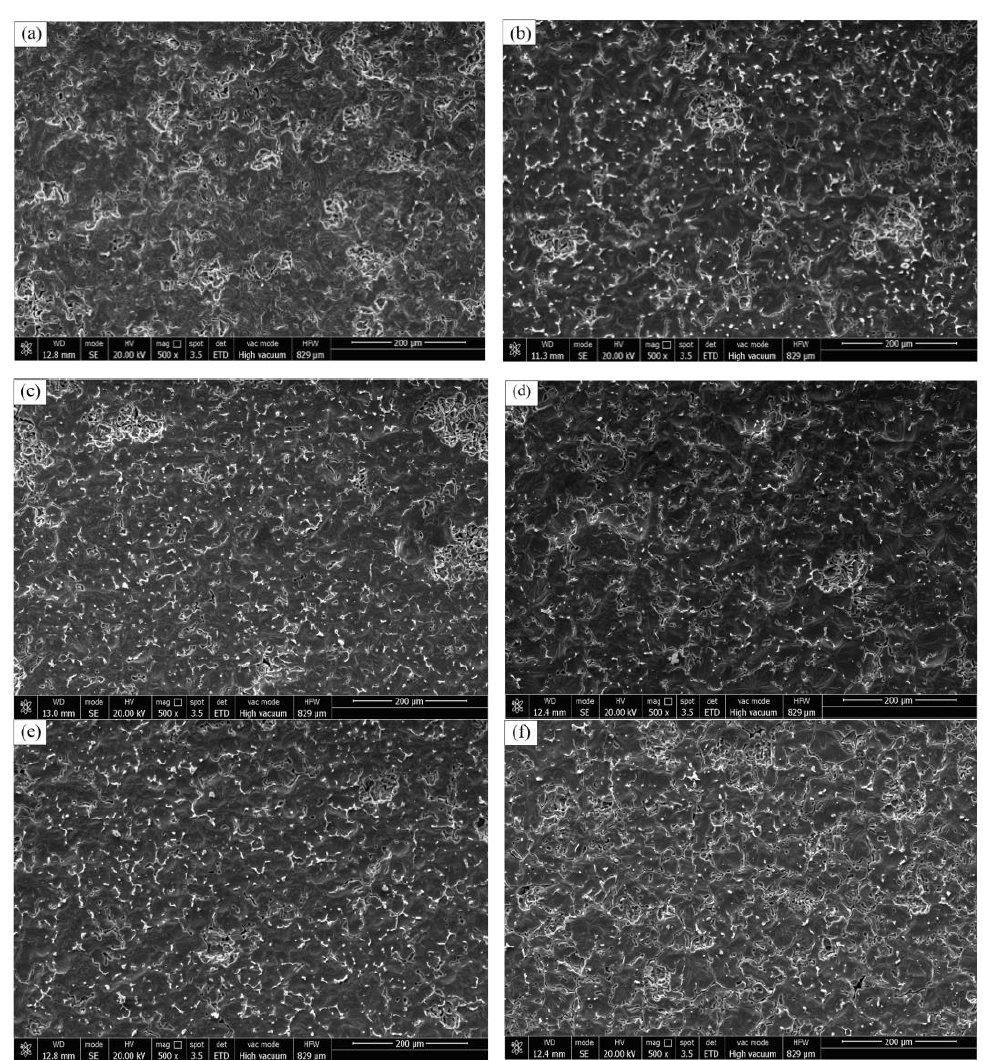
Figure 5. Surface morphology of the ZL205 alloy after 30-day corrosion after the addition of the Al- TiO 2 -C- X Er 2 O 3 refiner: ( a ) ZL205; ( b ) X = 0; ( c ) X = 2; ( d ) X = 4; ( e ) X = 6; ( f ) X = 8.